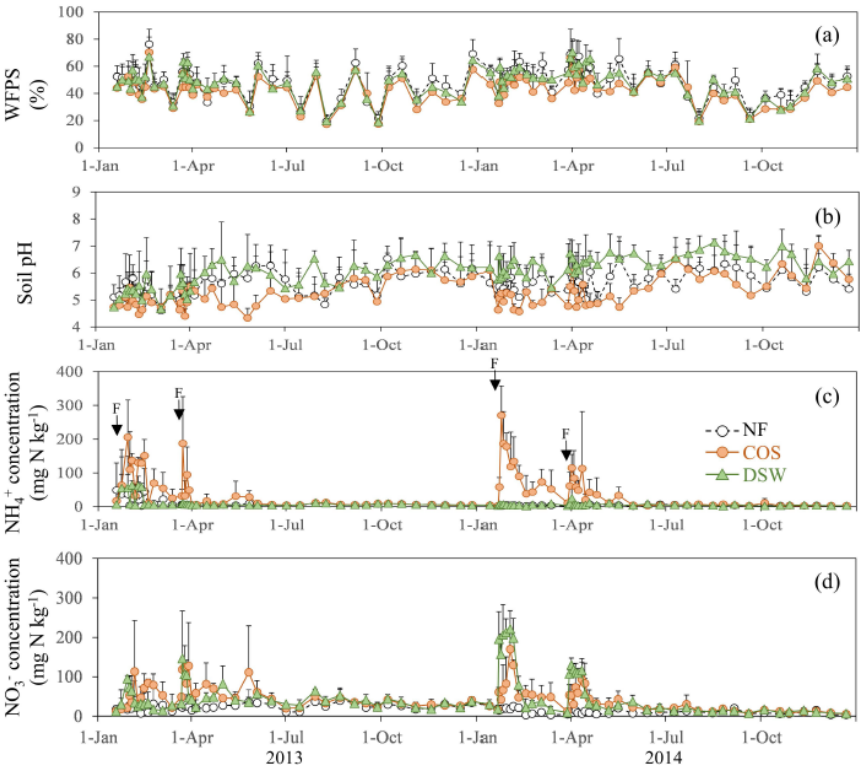
Figure 4. Seasonal variation in water ‐ filled pore space (WFPS) ( a ); soil pH ( b ); NH 4+ ( c ); and NO 3 − ( d ) concentrations during the study period in no fertilizer (NF), combined organic and synthetic fertilizer (COS), and distilled silage waste (DSW) treatments in a citrus orchard in southwestern Japan. Error bars represent standard deviations. F denotes fertilization.